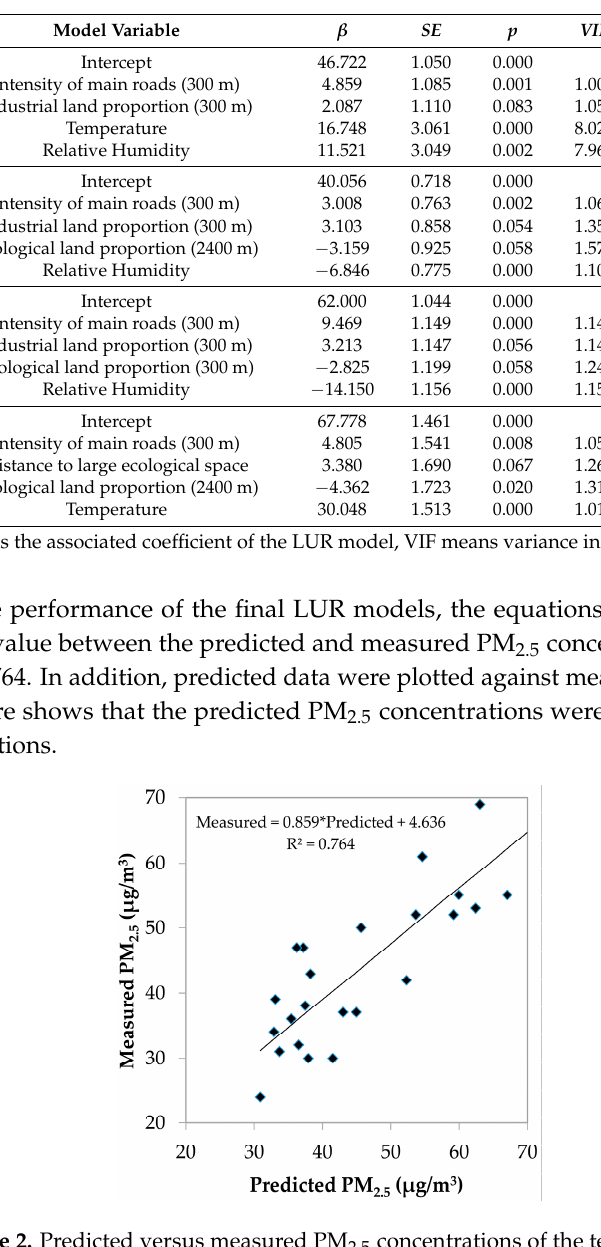
2.5 concentrations of the test data